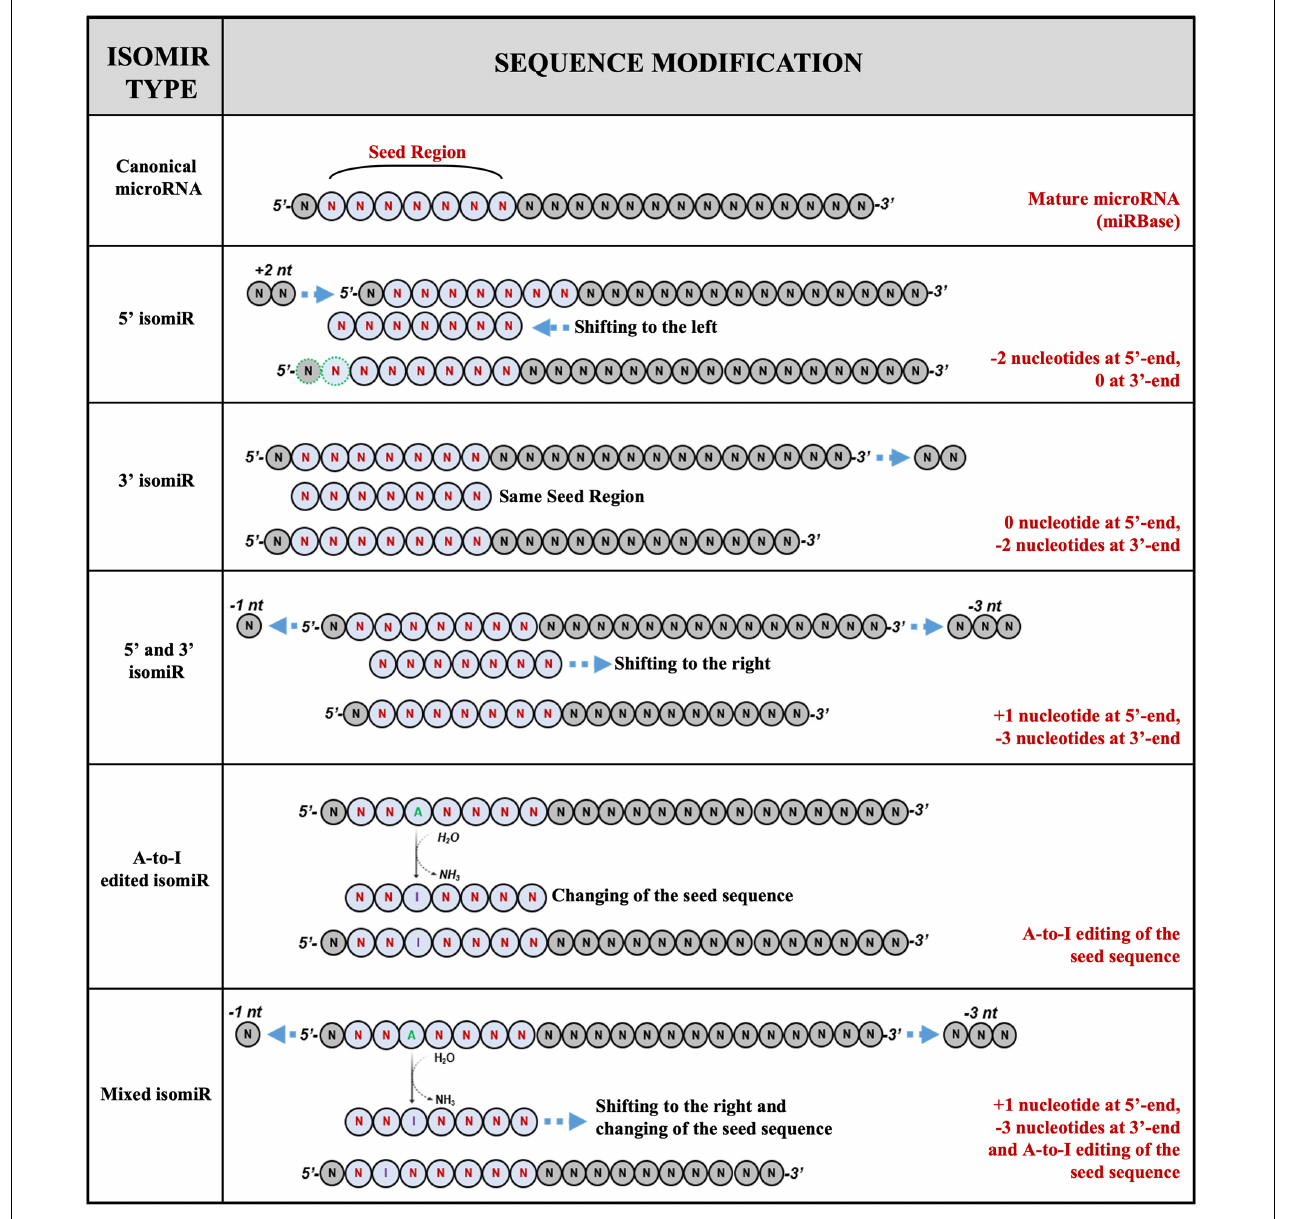
FIGURE 1 | Examples of isomiRs. MicroRNA isoforms can variate for length, sequence, or both. The current classification identified five classes of variants: (1) canonical microRNAs; (2) 5 (cid:48) isomiRs; (3) 3 (cid:48) isomiRs; (4) polymorphic isomiRs; (5) mixed type isomiRs.